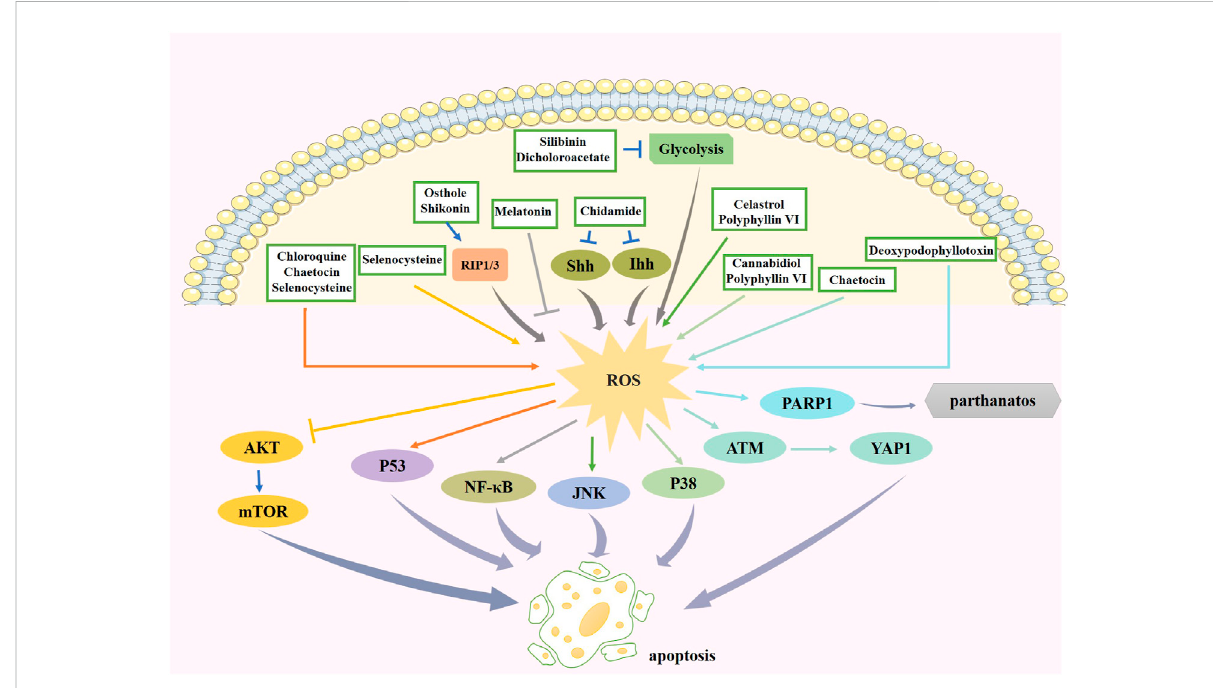
FIGURE 4 The effect and pathway of available therapeutic agents in glioma pertinent to ROS. Chidamide increases ROS production through the Hh signaling pathway. Melation promotes apoptosis by suppressing ROS production, leading to the reduction of its downstream factor NF- κ B. Chaetocin promotes ROS production and can promote apoptosis through the p53 pathway or the ATM/YAP1 pathway. Celastrol and polyphyllin VI promote ROS generation to induce apoptosis via JNK pathway. Osthole and shikonin increase ROS by promoting RIP1/3 expression. Increased ROS expression by selenocysteine inhibited Akt pathway on one hand and activated p53 pathway on the other hand to promote cell apoptosis. Increased ROS expression by polyphyllin VI and cannabidiol activates p38 pathway to induce apoptosis. Deoxypodophyllotoxin increases